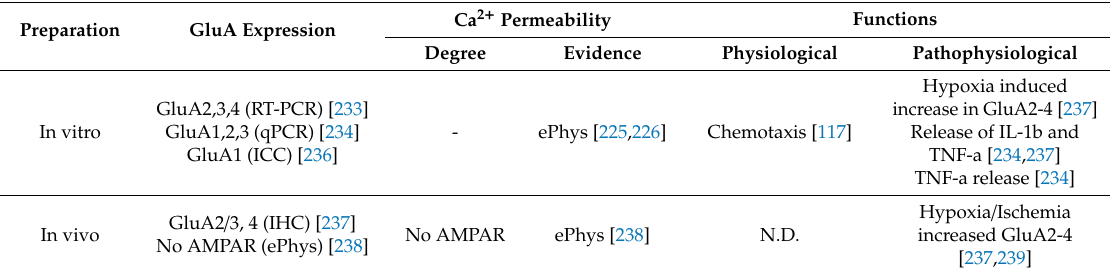
Table 3. Summary of AMPAR expression and functions in